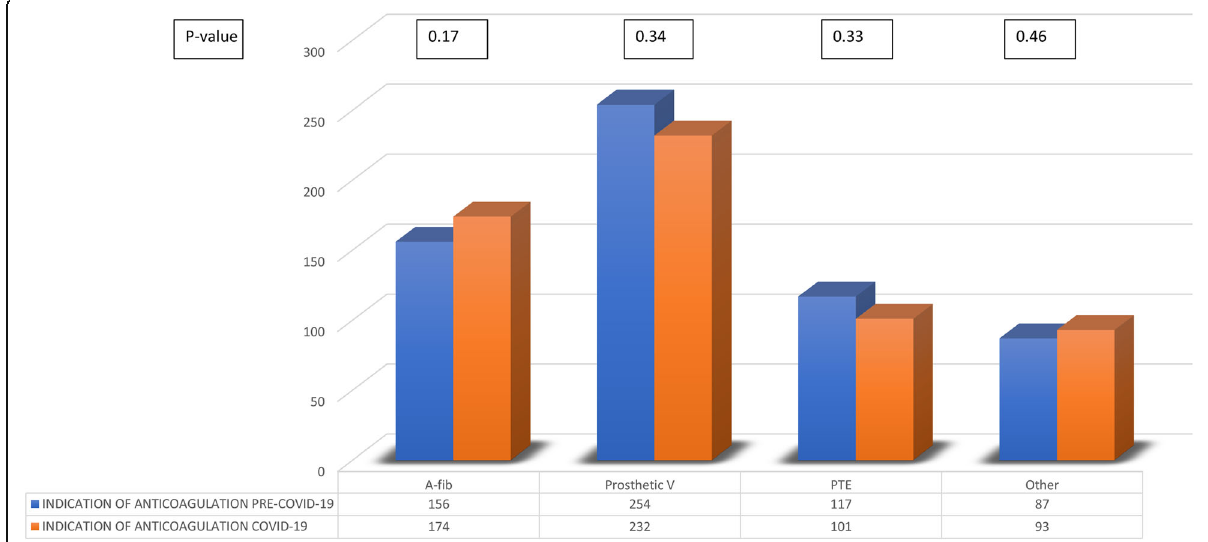
Fig. 2 Comparison of indication of anticoagulation in pre-COVID-19 phase versus COVID-19 phase (Afib, atrial fibrillation, PV, prosthetic valve, PTE, pulmonary thrombo-embolism)